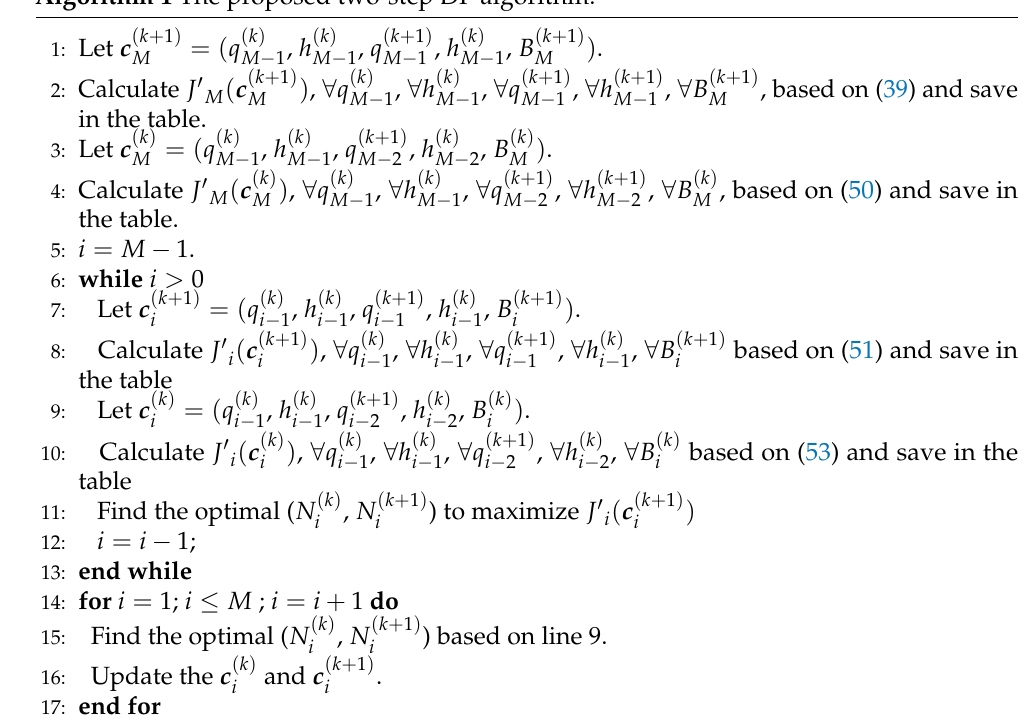
Algorithm 1 The proposed two-step DP